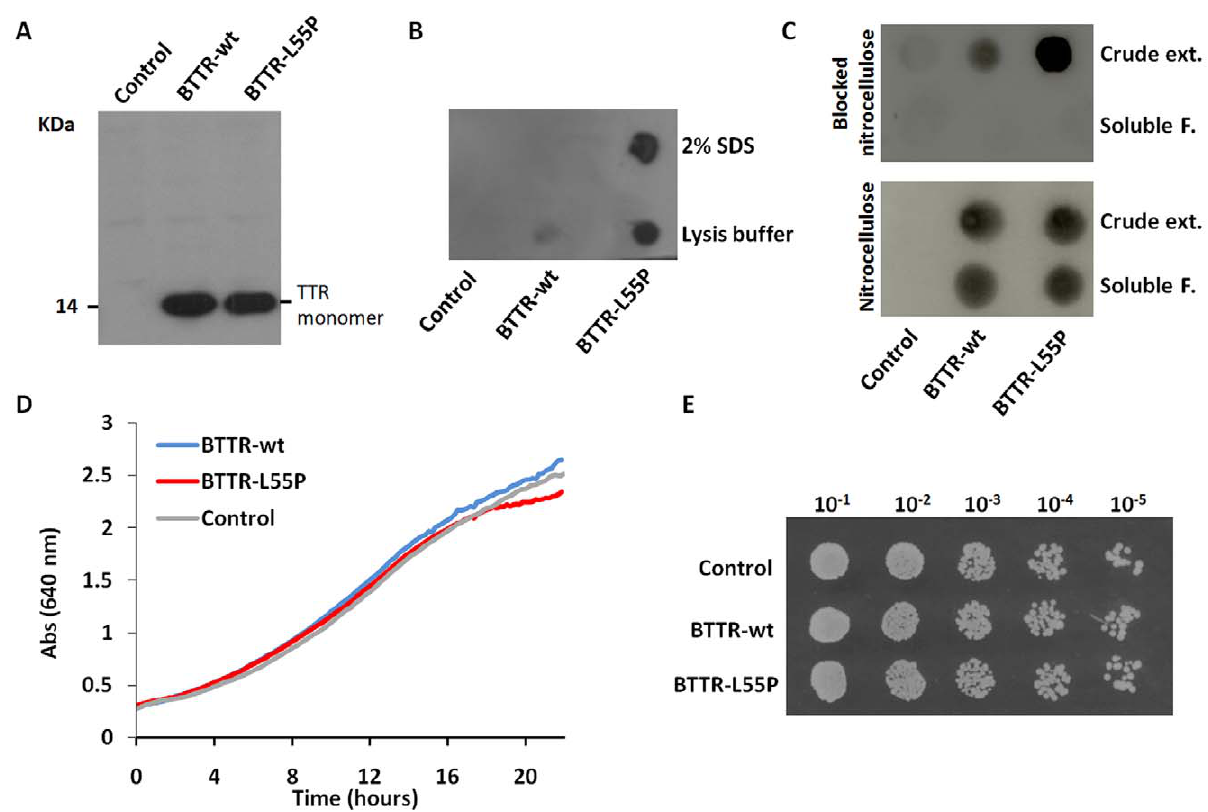
Figure 1. Characterization of TTR expression in yeast. (A) Relative quantitation of TTR-wt and TTR-L55P expression by Western blot with anti- human TTR antibody. Since TTR-L55P aggregates, electrophoretic separation of proteins was performed in the presence of urea to compare the total protein amount. TTR monomer is observed with molecular masses of approximately 14 kDa only in cells expressing TTR (BTTR-wt and BTTR-L55P). Similar expression levels were observed for the two TTR variants. (B) Protein aggregate filtration assay of insoluble protein fraction. TTR aggregates insoluble in 2% SDS were observed only in yeast cells expressing the amyloidogenic L55P variant (BTTR-L55P). This indicates that TTR-L55P when expressed in yeast forms high molecular mass amyloid-like aggregates, in contrast to TTR-wt. A substantially higher TTR amount was also found in the insoluble protein fraction of BTTR-L55P in comparison with BTTR-wt. (C) Control assay. The crude extract and the soluble protein fraction were analysed through a nitrocellulose membrane (as a regular dot-blot assay) and a nitrocellulose membrane that was blocked prior to the filtration procedure. Growth curves (D) and dilution spot assay (E) of yeast cells expressing the TTR variants and the control shows that, although the highly amyloidogenic TTR variant L55P was expressed in yeast, no changes were detected in yeast cell growth and cell viability.